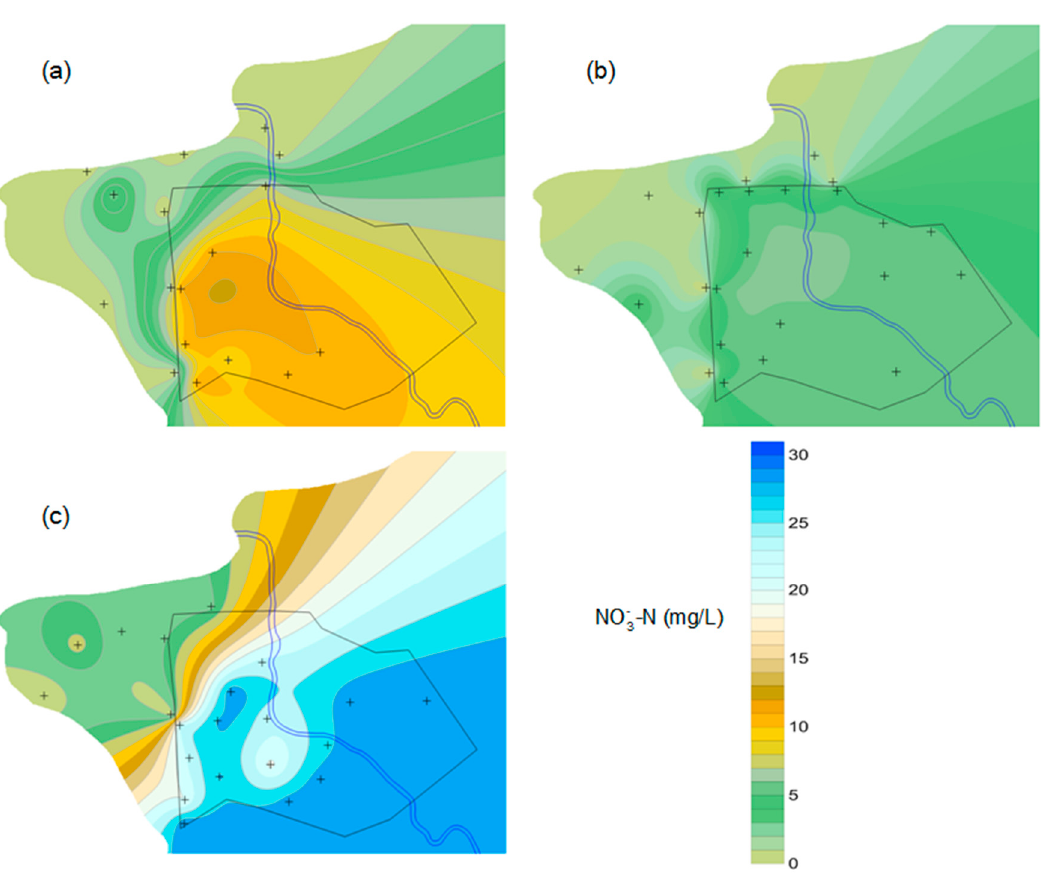
-N level in April, 3